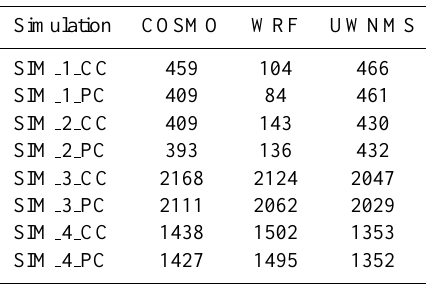
Table 4. Inter-model comparison of the total precipitation (mm) for the set of simulations in Table 2 after 10h